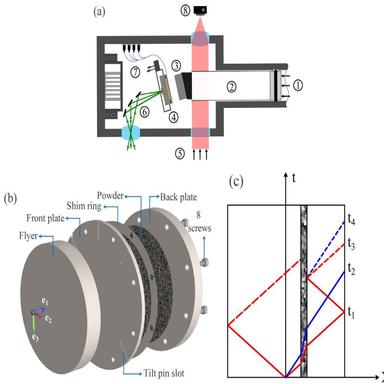
Schematics of experiment: (a) PSPI testing system with (1) pressurized gas, (2) projectile, (3) flyer plate, (4) target assembly, (5) line laser, (6) laser beams for interferometery, (7) tilt wires and (8) laser photodetector; (b) plate assembly configuration; (c) Lagrange (X-t) diagram with red line (normal wave) and blue line (shear wave); t1: normal wave arrival, t2: shear wave arrival, t3: end of normal wave, t4: end of shear wave (unloading denoted by the dashed line).